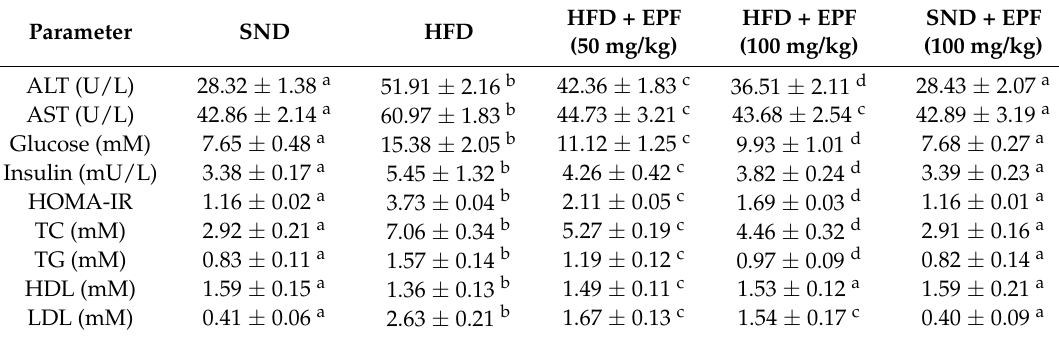
Table 3. Effect of EPF on serum biochemical parameters of